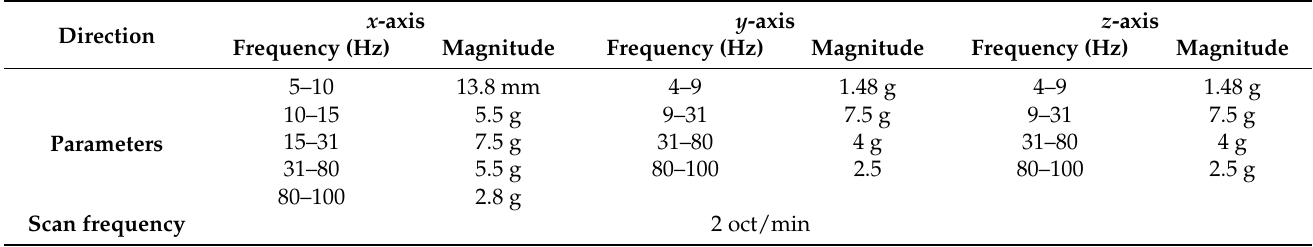
Figure 13. Location of sampling points. Table 3. Sine vibration test conditions.